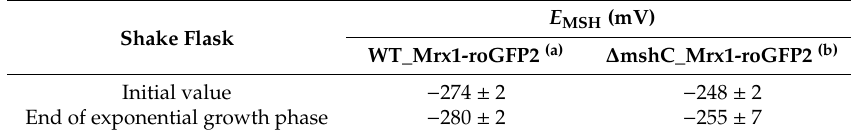
Table 1. Mycothiol (MSH) redox potential ( E MSH ; Nernst equation) during shake flask cultivations.